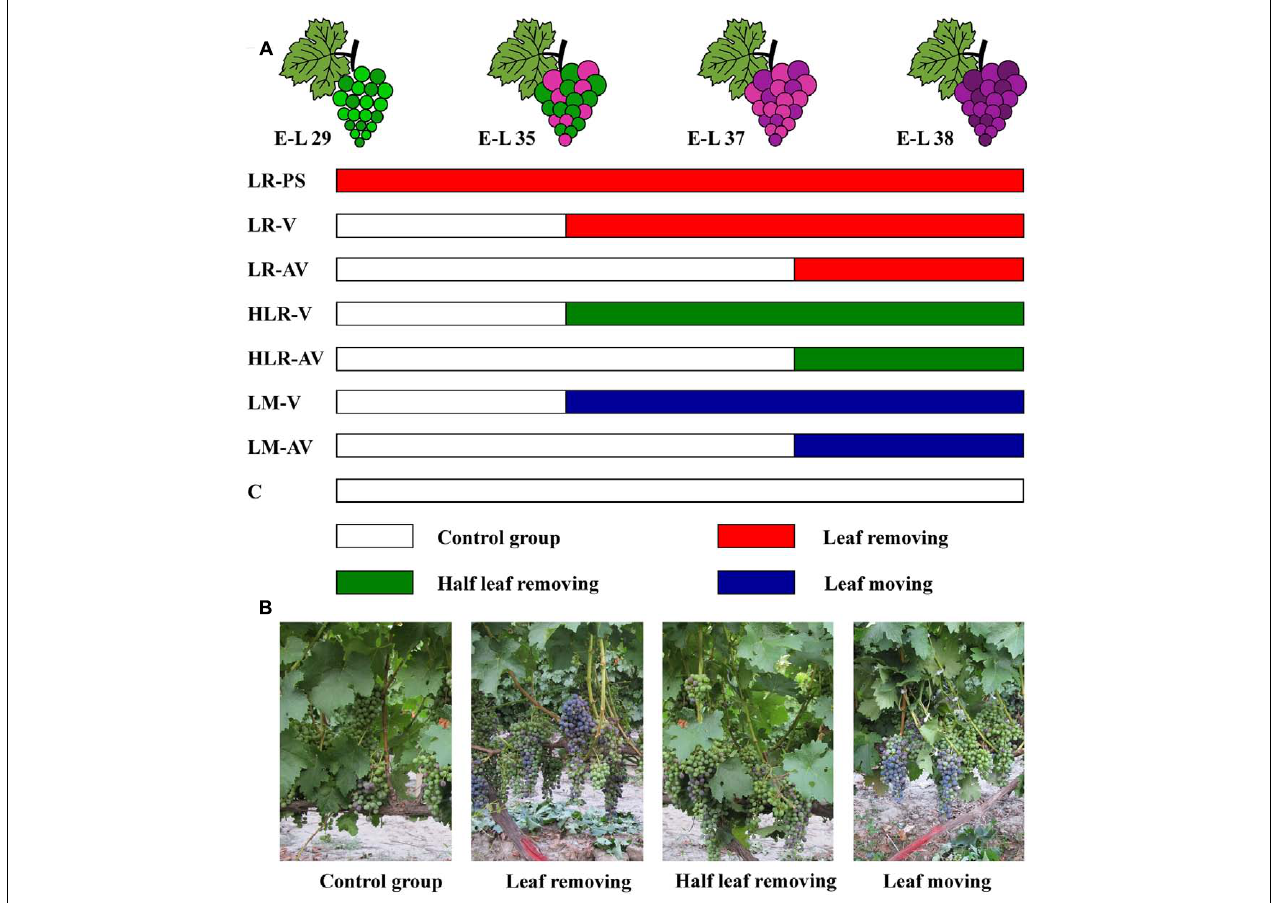
FIGURE 1 | (A) Experimental design for different cluster sunlight exposure treatments and (B) field photographs of Cabernet Sauvignon grapes under different sunlight exposure treatments. LR-PS, leaf removal at berry pepper-corn size; LR-V, leaf removal at véraison; LR-AV, leaf removal after véraison; HLR-V, half leaf removal at véraison; HLR-AV, half leaf removal after véraison; LM-V, leaf moving at véraison; LM-AV, leaf moving after véraison; C, control